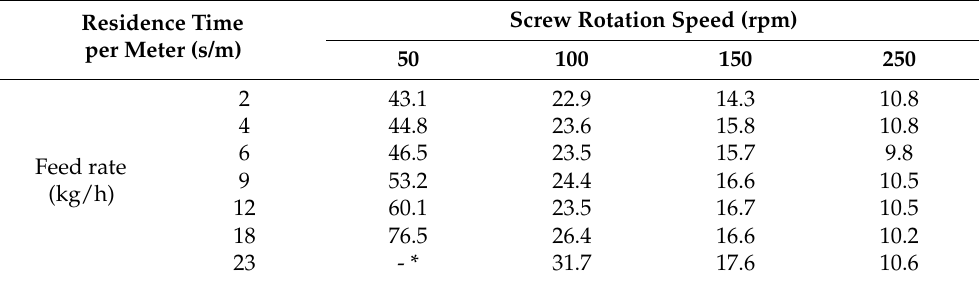
Table 1. Residence time per unit meter of solid pellets transported on the full-flight screws at 30 ◦ C.